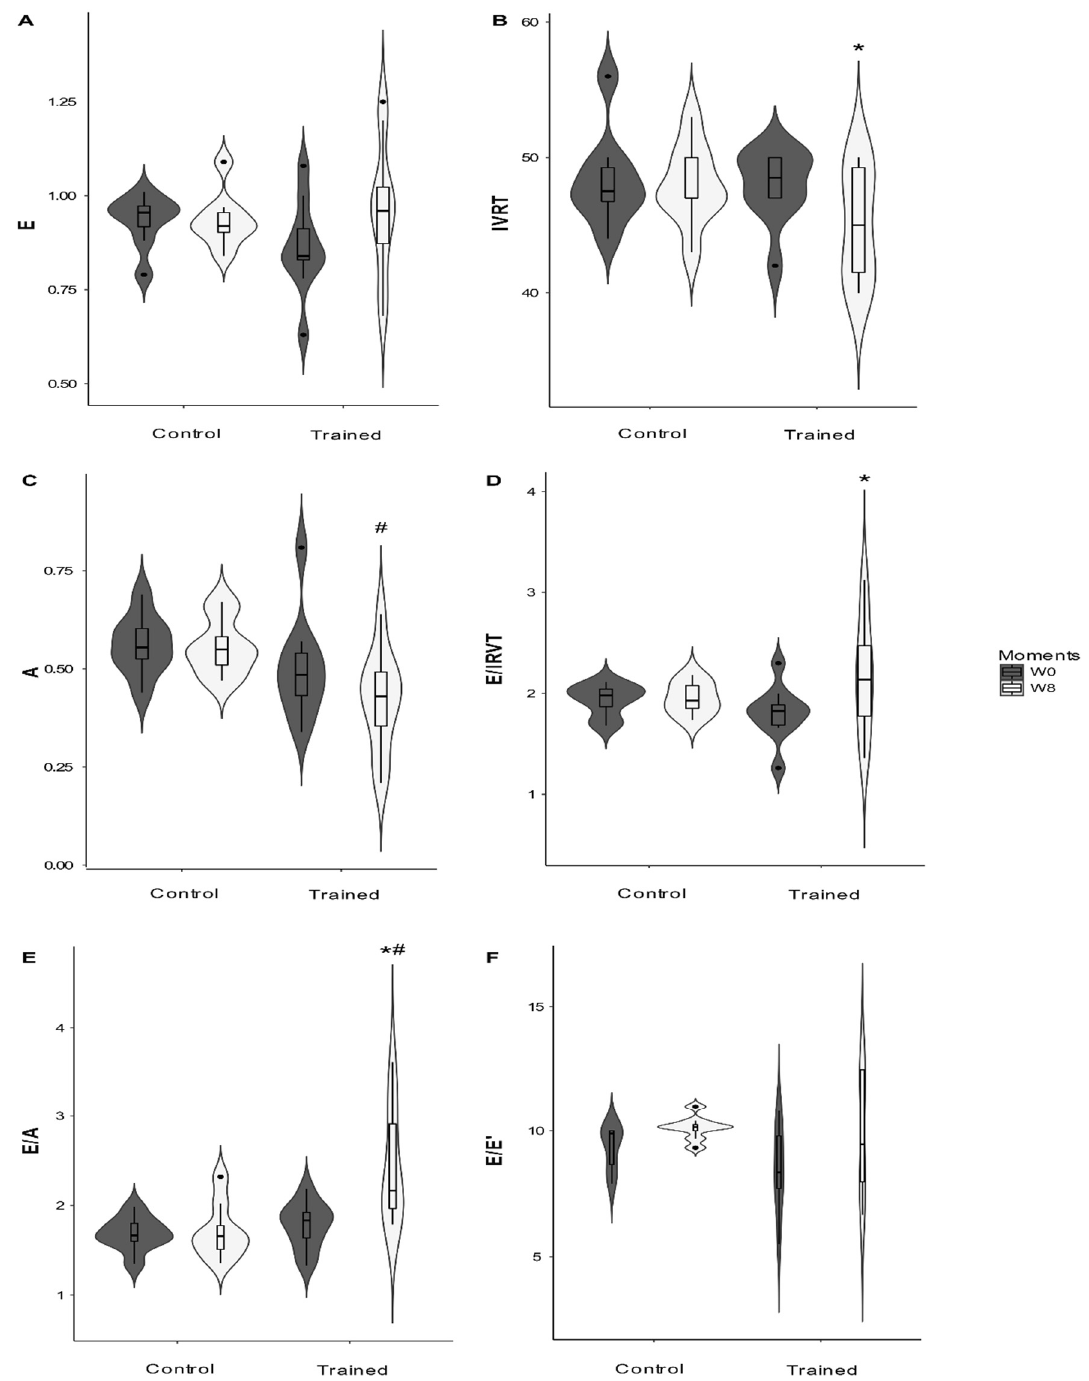
Figure 4. Changes in the diastolic function of dogs submitted to 8 weeks of physical training. E: the velocity of early ventricular filling velocity ( A ); IVRT: isovolumetric relaxation time ( B ); A: the velocity of late ventricular filling velocity ( C ); E/IVRT: the ratio of early ventricular filling velocity to isovolumetric relaxation time ( D ); E/A: the ratio of early-to-late left ventricular filling velocities ( E ); E/E’: ratio of the mitral flow E wave and mitral annulus E’ wave velocities ( F ). *: Difference compared to week zero (W0); #: Difference between groups ( p < 0.05).